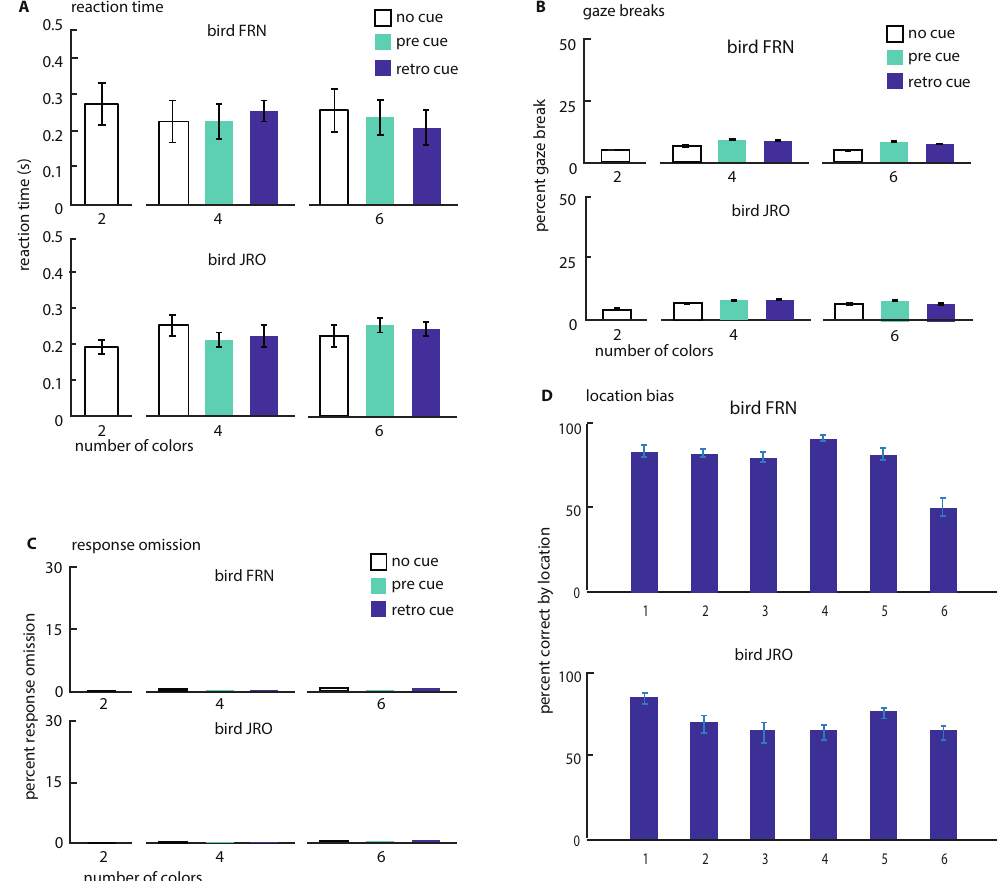
Figure 3. Reaction time and behavioral bias of both crows as a function of WM-load and cue-condition. Error- bars are SEM. ( A ) Reaction time on correct trials is not systematically affected by WM-load or cue-condition. ( B ) Percent trials with of gaze-breaks (head-movement during the trial) is slightly increased on cued trials. ( C ) Percent trials with response-omission (no response at the end of the trial) is unaffected by task-condition. ( D ) Percent correct as a function of stimulus location. Bird FRN has a lower performance on one